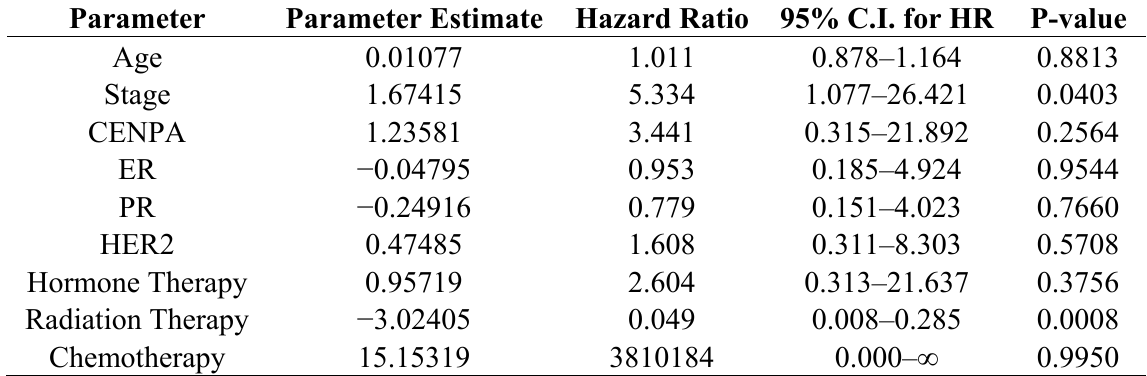
Table 3. Univariate analysis showing hazard ratios (HR), Confidence intervals (C.I.) and P values in the breast cancer patient